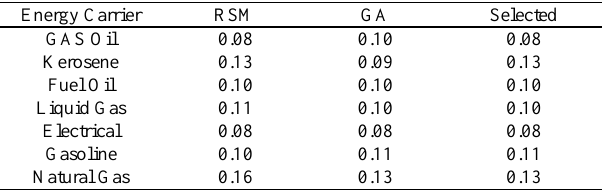
Table 6. Optimized learning ratios for the created networks.